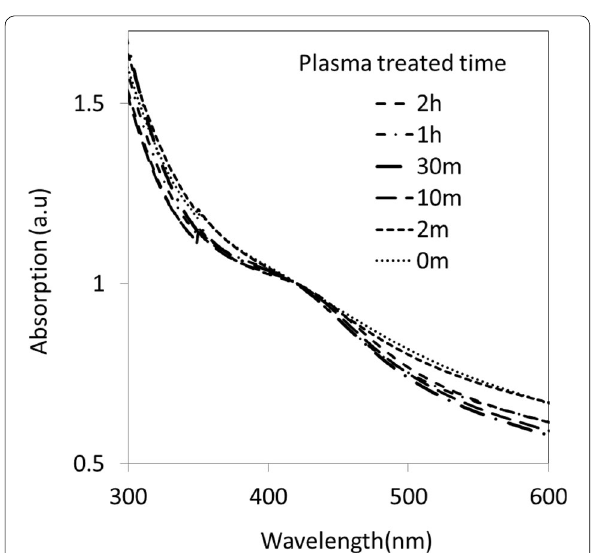
Fig. 2 Absorption spectra of AgNP seed-fabricated PDMS films subjected to various times of plasma